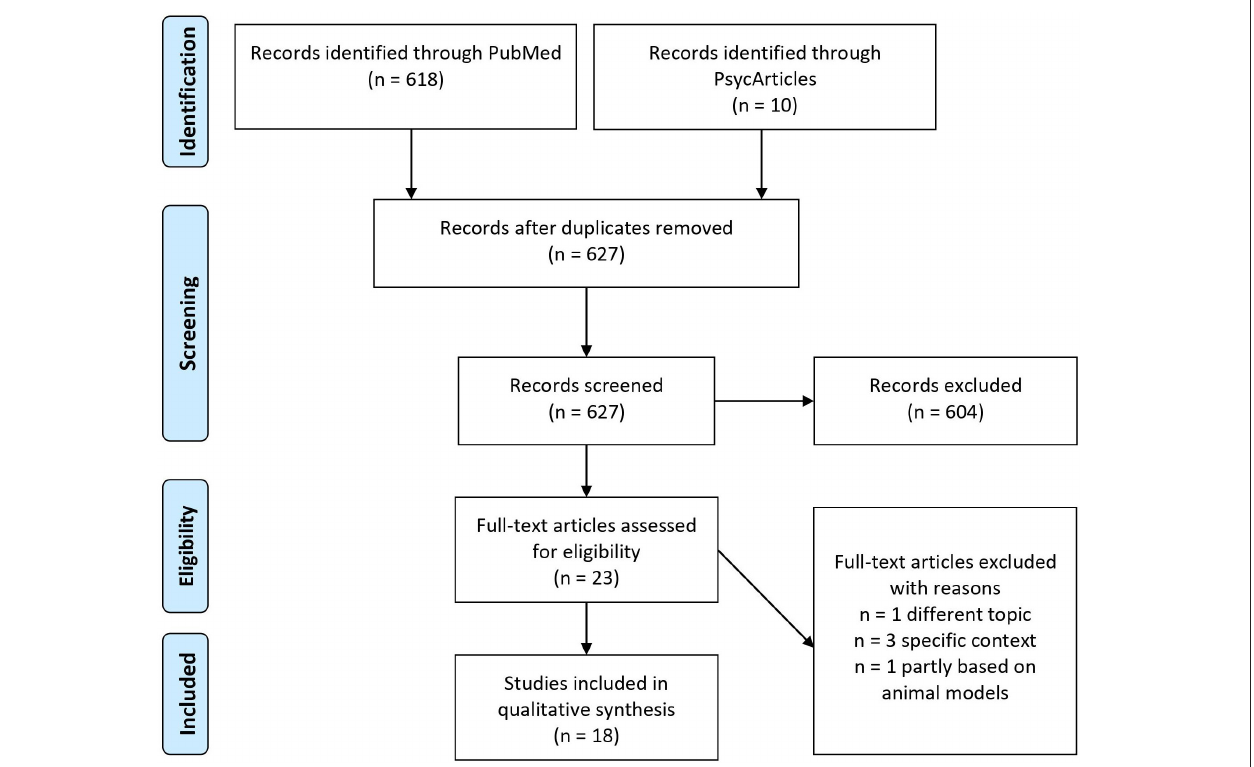
FIGURE 1 | PRISMA search